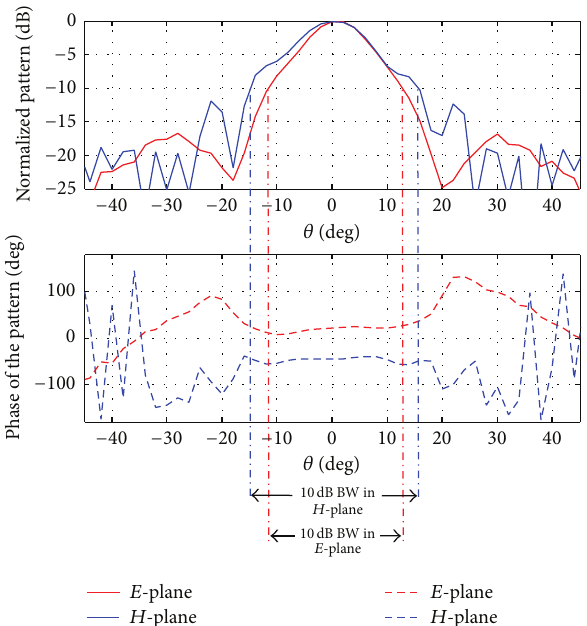
Figure 2: Radiation patterns and corresponding phase variations at phase centers in E- and H